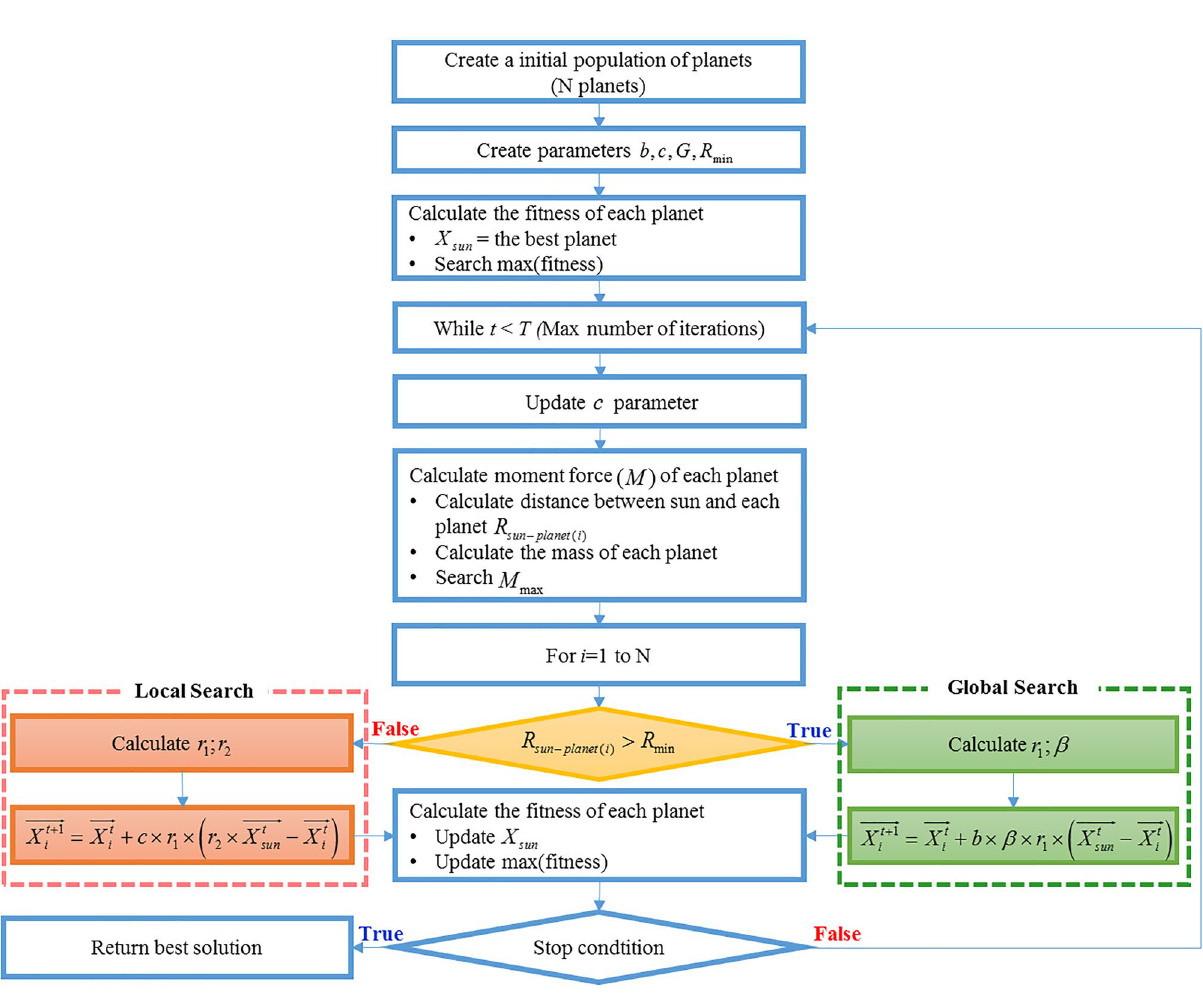
Figure 5. Flow chart of the proposed